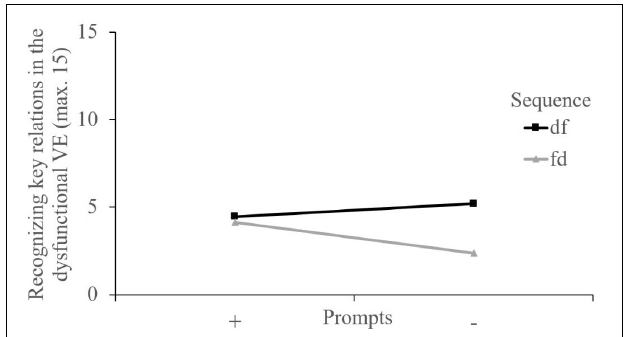
FIGURE 3 | Interaction plot regarding recognizing key relations in the dysfunctional video example. VE, video